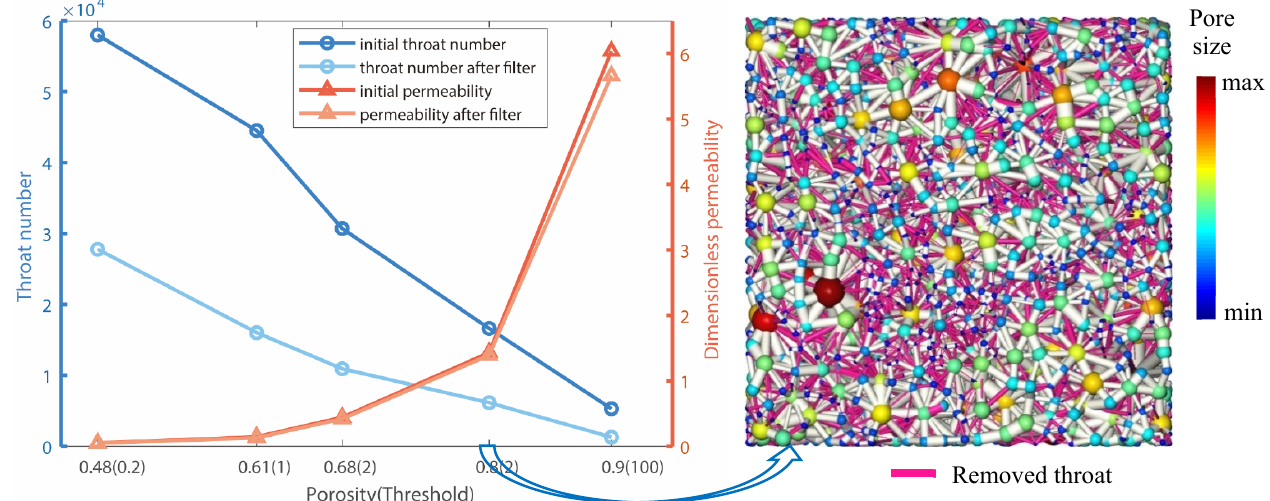
Figure 3. Figure 3. Impact of threshold value on throat filter. The threshold values applied for fibrous porous structures with porosities of 48%, 61%, 68%, 80%, and 90% are 0.2, 1, 2, 5, and 100, respectively. The effects are promising since a large portion of throats can be removed with little impact on the permeability values.